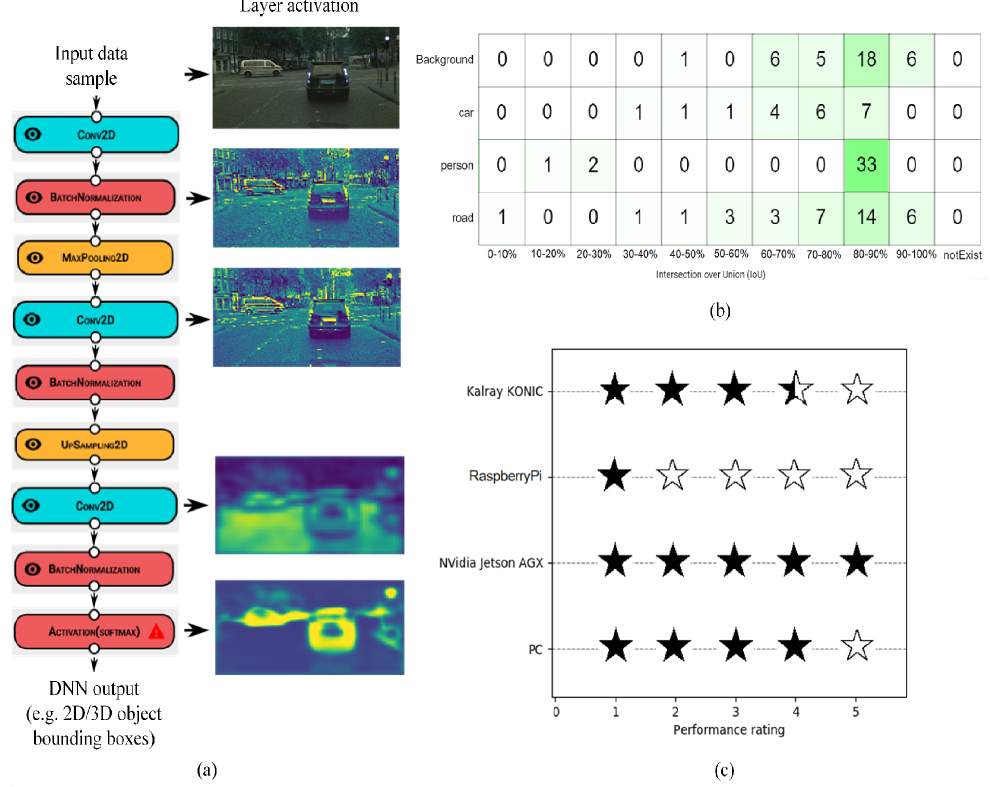
Figure 9. Performance evaluation metrics within EB-AI. ( a ) Direct visualization of the activations of each DNN layer. ( b ) Intersection over Union (IoU) evaluation matrix describing in percentage the amount of overlapping bounding boxes. ( c ) Five-star rating aggregates overall